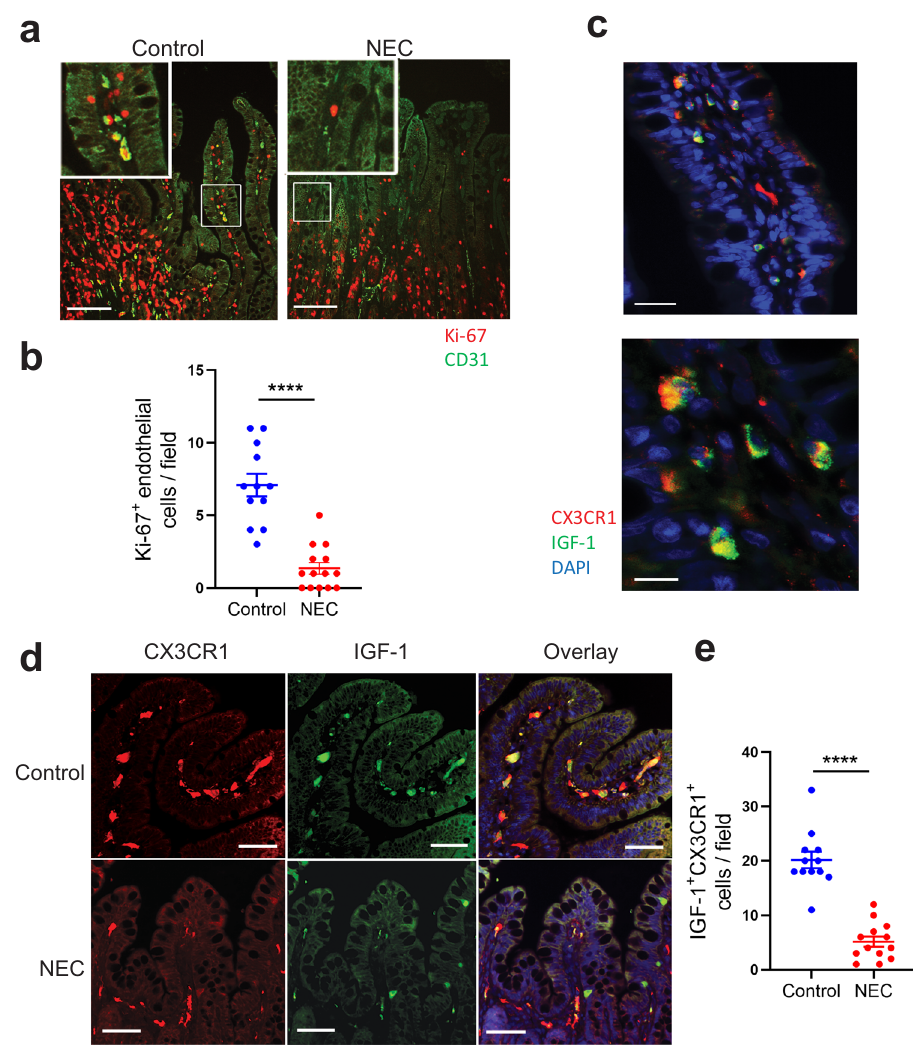
Fig. 8 Endothelial cell proliferation is diminished and the number of IGF-1-producing macrophages is decreased in the intestine of human neonates with NEC compared to controls. a , b Sections of human NEC ( n = 4) and control ( n = 5) intestinal tissues were stained for CD31 (green) and Ki-67 (red). 2 – 3 images per sample from non-necrotic area were taken at ×20 and proliferating endothelial (CD31 + Ki-67 + ) cells were counted. a Typical images are shown here. b Number of proliferating endothelial cells (represented by each dot) per ×20 image (mean ± SEM), scale bar = 100 µ m. c Images of control human neonatal intestinal tissue sections subjected to in situ hybridization using a probe for IGF-1 (green) and counterstained for macrophages using anti- CX3CR1 antibodies (red); bar = 25 (top) and 10 µ m (bottom). d , e NEC and control tissue sections were stained by immuno fl uorescence for IGF-1 (green) and the macrophage marker CX3CR1 (red). d Typical images are shown. Overlay image includes DAPI, scale bar = 100 µ m. e Graph represents the number of IGF-1 + CX3CR1 + cells per fi eld (mean ± SEM, 3 – 4 ×20 fi elds of non-necrotic area were taken from each sample; n = 4 patients/group). P values were calculated using two-sided Student ’ s t tests ( b and e ). **** p < 0.0001. Source data are provided as a Source Data fi out by monocyte-derived macrophages during postnatal devel- opment in mice 23 . Here, we show that neonatal intestinal mac- rophages promote intestinal endothelial cell proliferation and mucosal microvascular development. Also, although the mechanism remains to be explored, our in vitro data suggest that macrophages sense endothelial cells to produce increased levels of IGF-1. Macrophages have been shown to play a role as accessory cells to promote angiogenesis in the heart. In the injured heart, neonatal mouse embryonic-derived macrophages but not adult macrophages promote cardiac recovery and ef fi ciently stimulate endothelial cell tube formation in vitro 31 . In the embryo, yolk sac- derived embryonic macrophages promote coronary development via IGF-1 24 . Our data are the fi rst to suggest a role for macrophage-derived IGF-1 in promoting neonatal intestinal microvascular development.